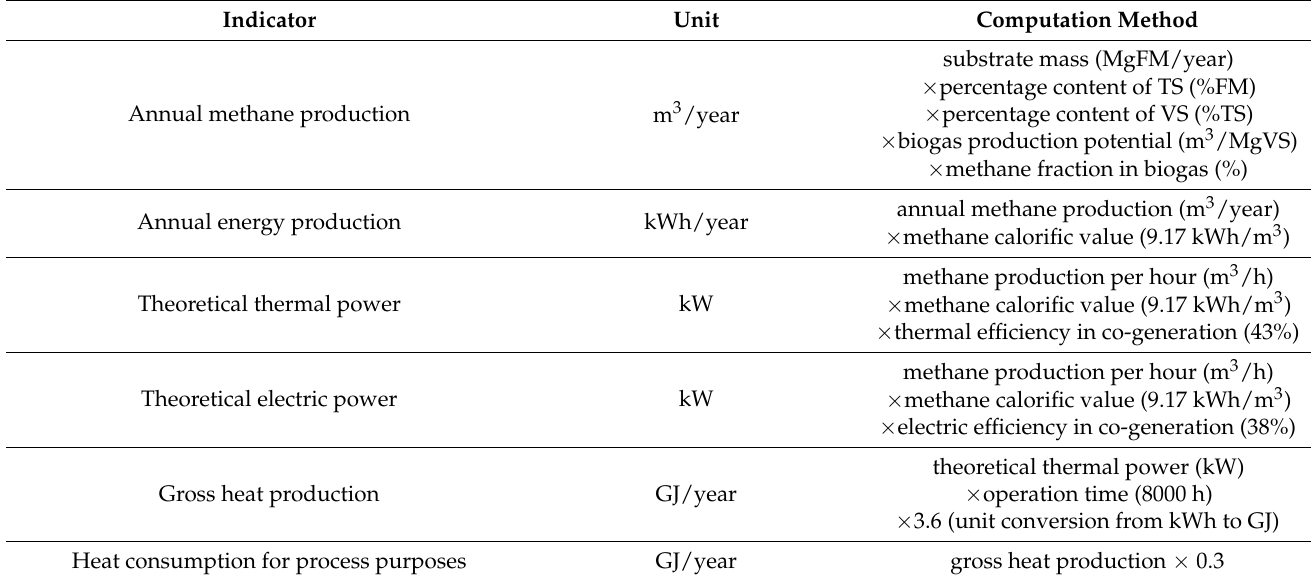
Table 5. Methodology of estimating energy